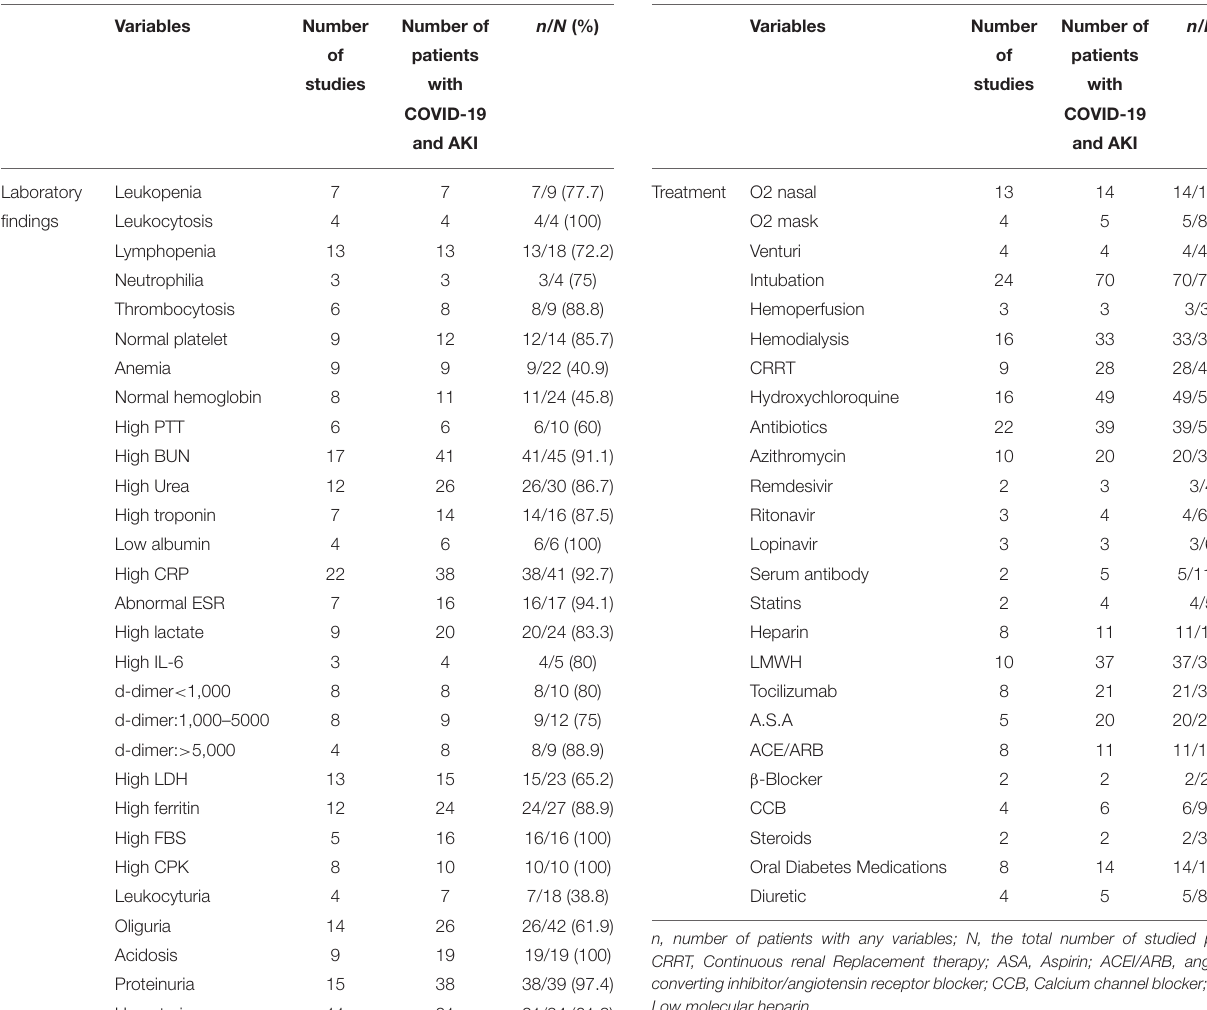
TABLE 4 | Laboratory findings in the included studies. TABLE 5 | Treatment agents used in the included